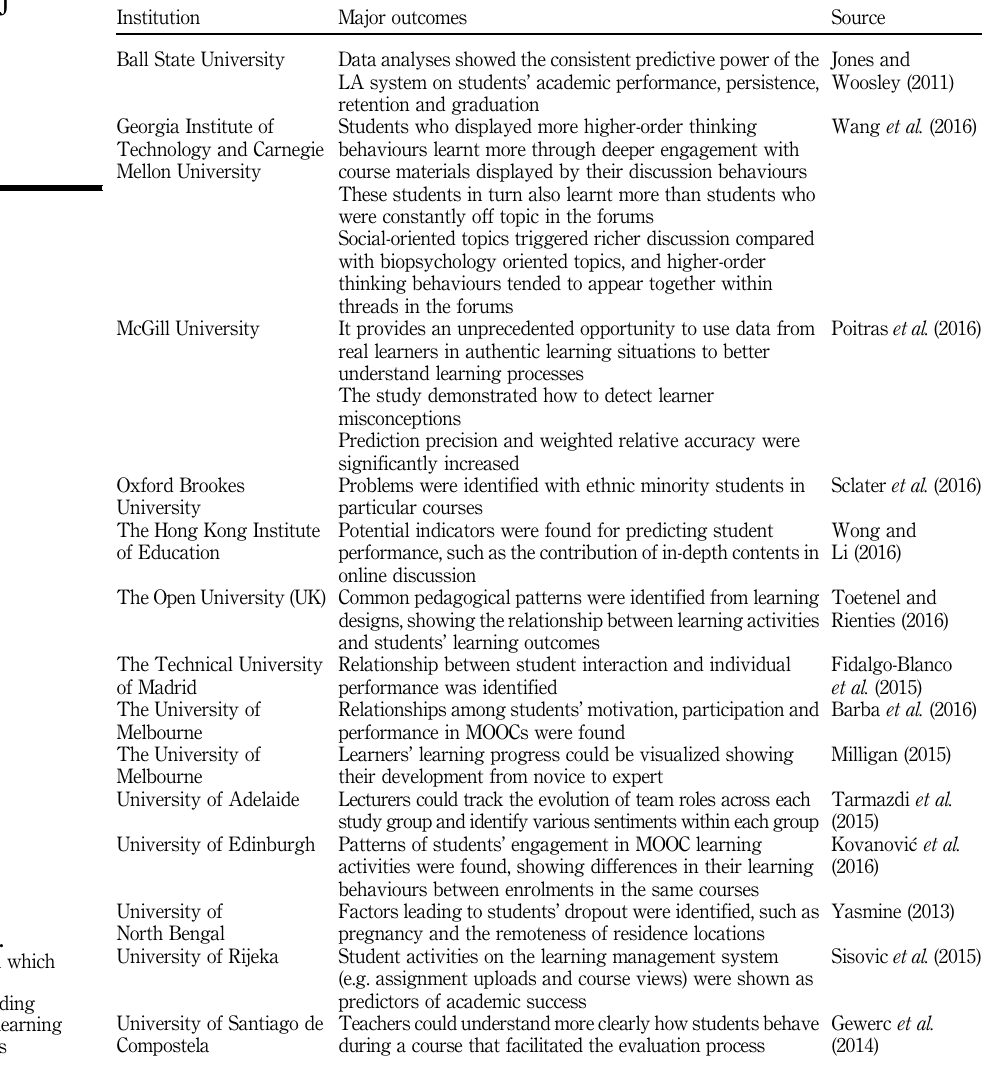
Table IV. Use of LA which helped in understanding students ’ learning